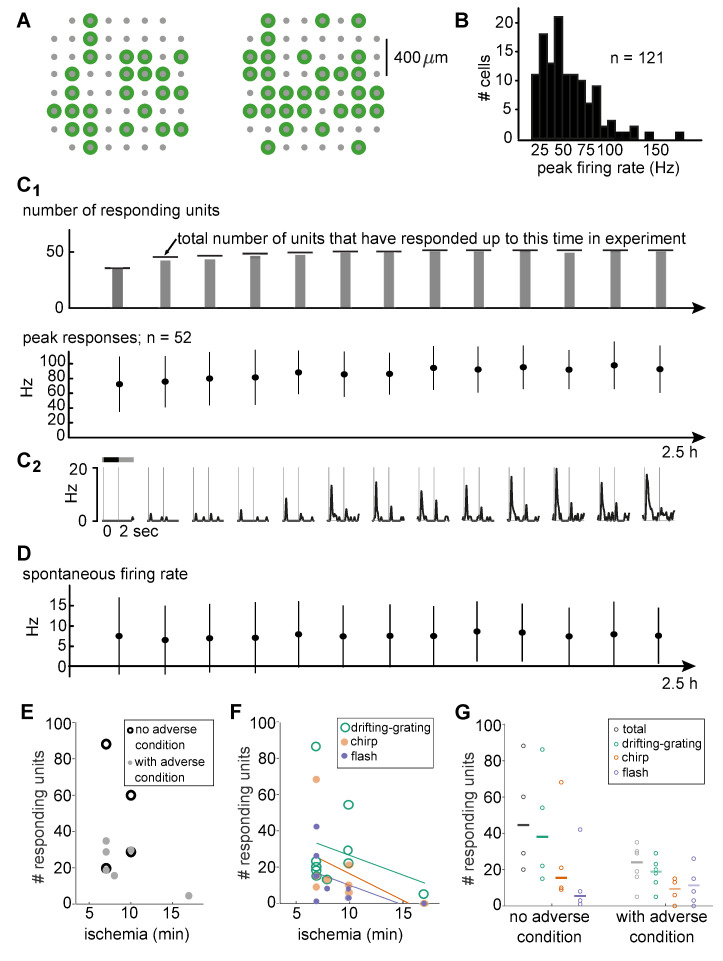
Donated human retinas are healthy.(A) Multi-electrode array layout (gray) and electrodes with sortable, light-responsive cells (green) of two example experiments. Responding cells are distributed across the recorded retinal pieces. (B) Distribution of peak firing rates in response to full-field contrast steps. (C1) Top: Number of cells responding at any given time point (gray bars) was similar to the total number that had responses until that time point (horizontal lines). Bottom: Mean ± standard deviation of peak firing rate for the responding cells. Data from a subset of experiments that lasted for 2.5h (N = 4 experiments, N = 52 cells). (C2) Example firing rate traces for one cell. (D) Spontaneous background firing rates (mean ± standard deviation) of the same cells and time points as in C1. (E) Number of responding units and ischemia time for donors without (black) and with (gray) known adverse condition (indicated in Table 1). (F) Number of responding cells for individual stimuli as a function of ischemia time. Lines indicate linear fits. (G) Total number of responding cells and responses per stimulus for donors with and without known adverse condition. Lines indicate median numbers.